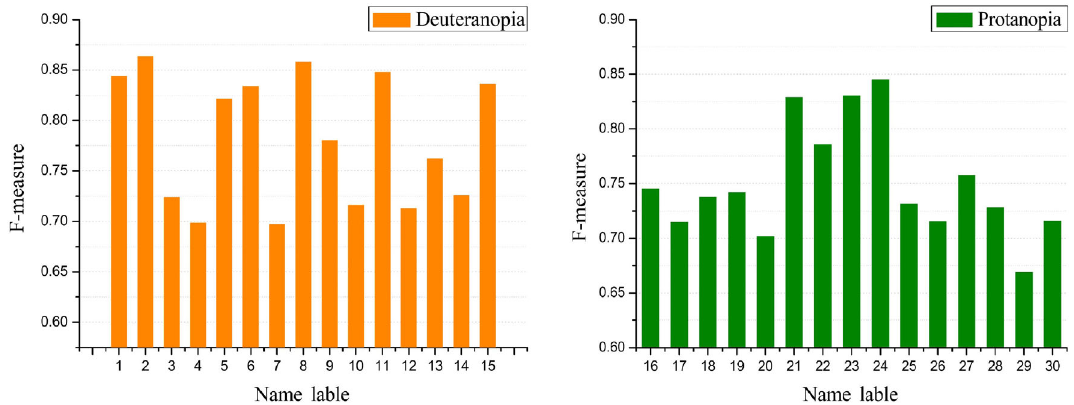
Fig. 14 F-measure for our method. Left: deuteranopia, right: